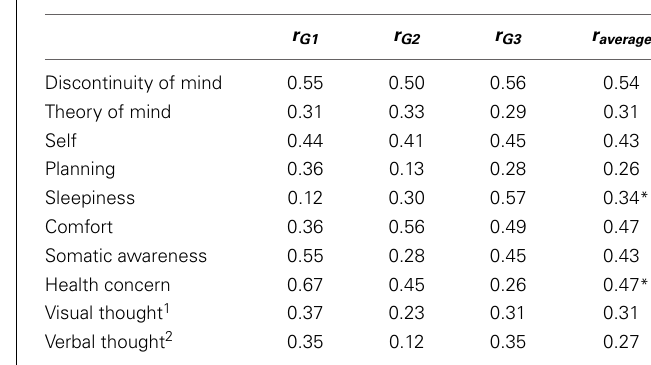
Table 2 | Test-retest correlations between first (ARSQ 1.0) and second (ARSQ 2.0) assessments based on mean